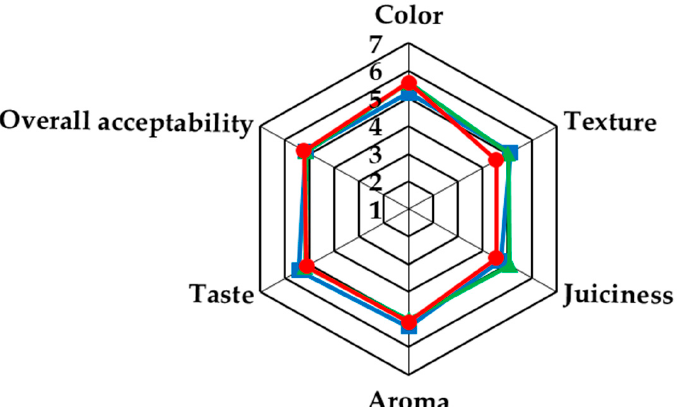
Figure 4. Sensory analysis scores for color, texture, juiciness, aroma, taste, and overall acceptability of the fermented sausages. ( ■ ) Control: 18% pork backfat; ( ▲ ) SB60: 9% pork backfat and 9% B60 bigel; ( ● ) SB80: 9% pork backfat and 9% B80 bigel. Table 1. Nutritional composition and changes in the energy, fatty acids, cholesterol, and protein of uncooked fermented sausages per 100